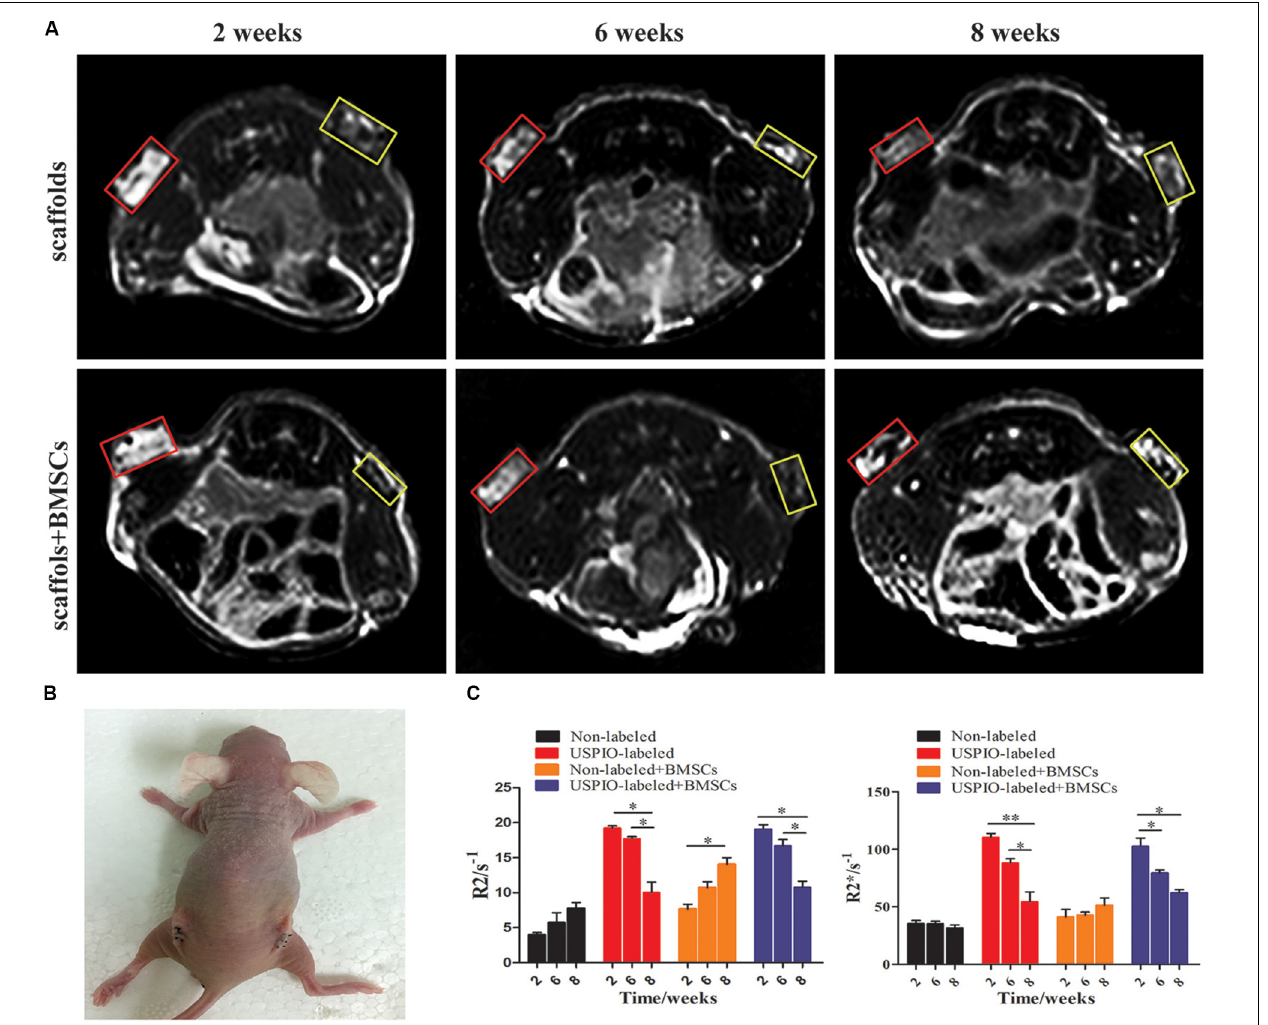
FIGURE 6 | Ectopic osteogenesis model and MR analysis for in vivo studies. (A) MRI of scaffolds implanted nude mice at 2, 6, 8 weeks (yellow box: USPIO-labeled scaffolds, red box: non-labeled scaffolds). (B) Scaffolds implanted on the back of the nude mice bilaterally. (C) Quantitative R2- and R2*-relaxometry analysis (* P < 0.05, ** P < 0.01, or *** P <